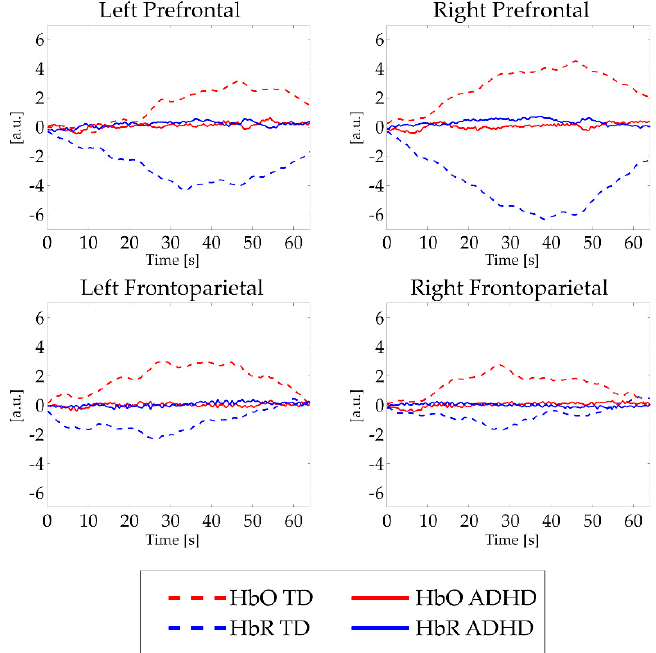
Figure 3. Mean fNIRS activations in all task conditions. Note: a.u. = Arbitrary units; s = seconds. Red lines indicate HbO signal, blue lines depict HbR signal. Hatch pattern represents activations from typically developing children, continuous lines illustrate activations in children with